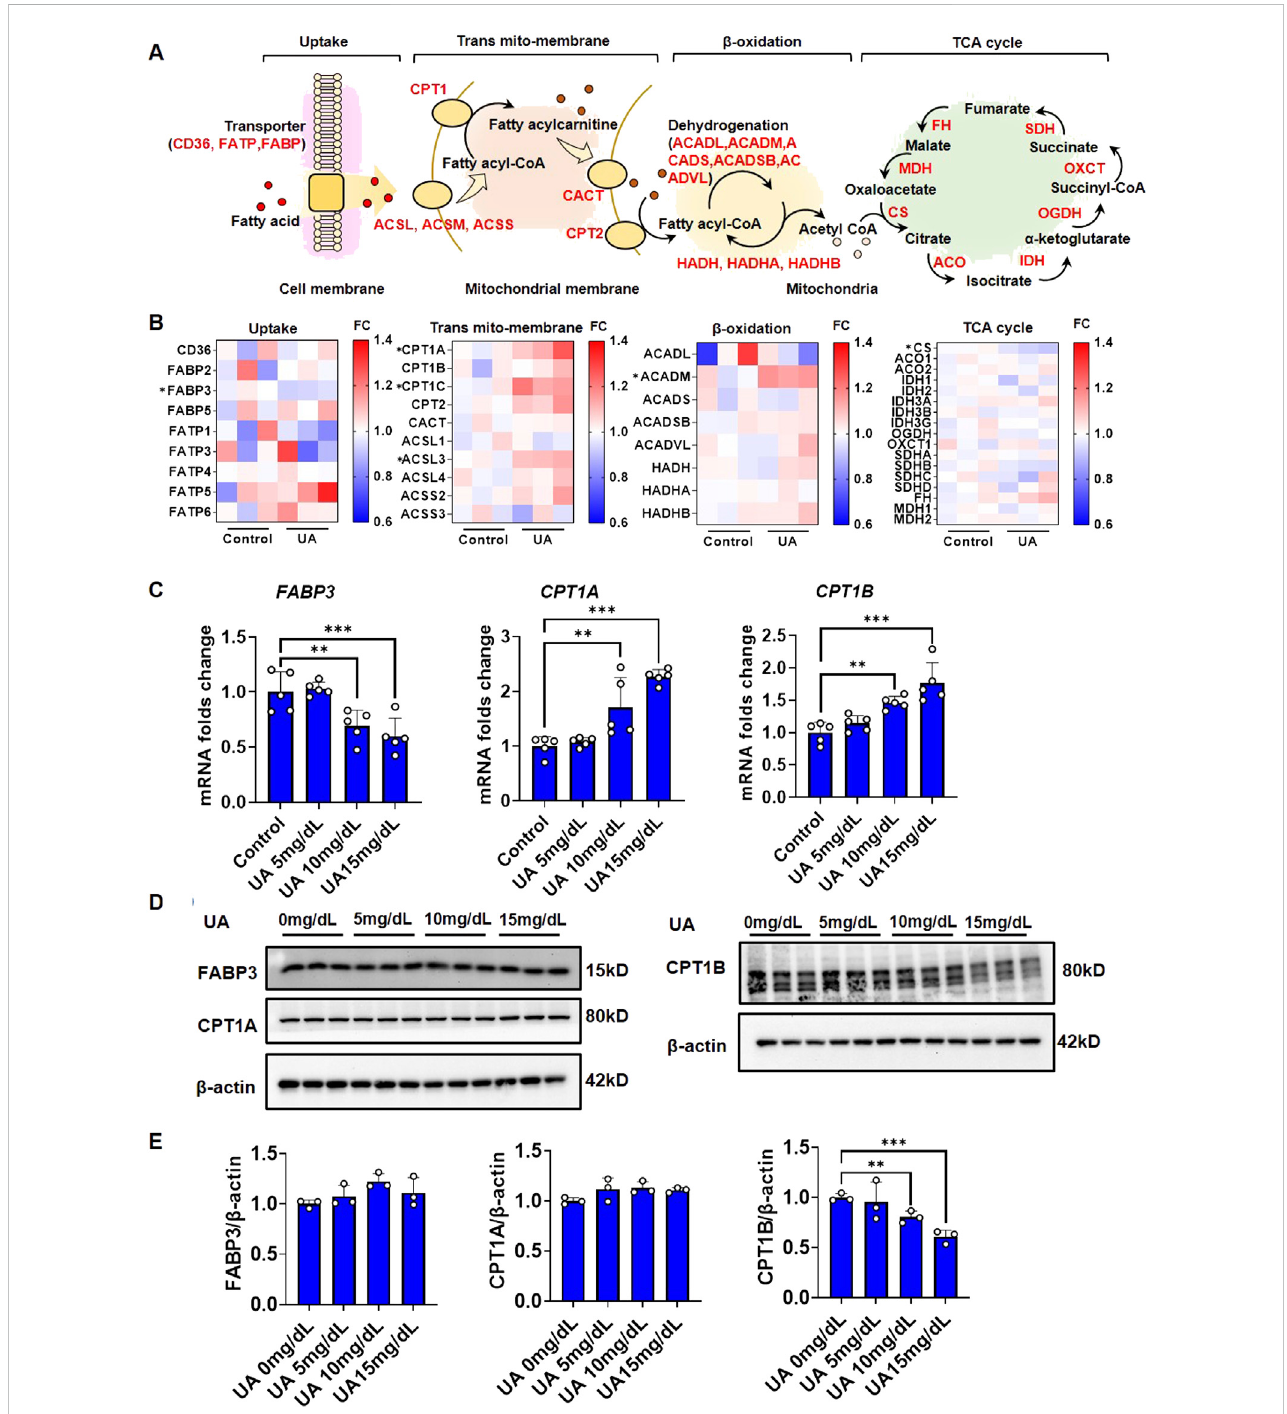
FIGURE 2 FA metabolic genes response under UA stimulation. (A) Diagram of steps and participated genes in fatty acid metabolism; (B) Heatmap re fl ect the expressionfoldchangeoffattyacidmetabolicgenesineachstep.TheexpressiondataweregeneratedfromRNAseq; (C) ImpactofUAonthegeneexpression fold change of FABP3, CPT1A and CPT1B. The cells were harvested after 24 h treatment followed by qPCR. The results were normalized to the mean value of control ( n = 5); (D) Impact of UA on the protein level of FABP3, CPT1A and CPT1B. The cells were harvested after 1 h treatment followed by western blot analysis. β -actin was used as an internal loading control; (E) The quanti fi cation of Figure